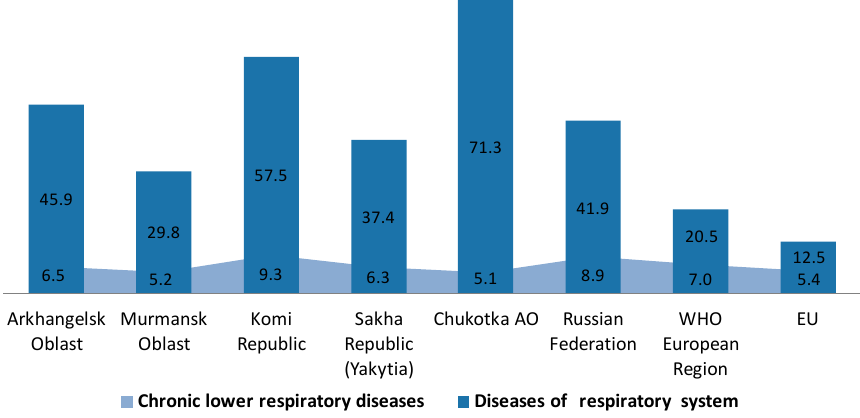
Figure 2. Standardized death rates of respiratory diseases and chronic lower RD per 100,000 in selected regions of the Russian North.